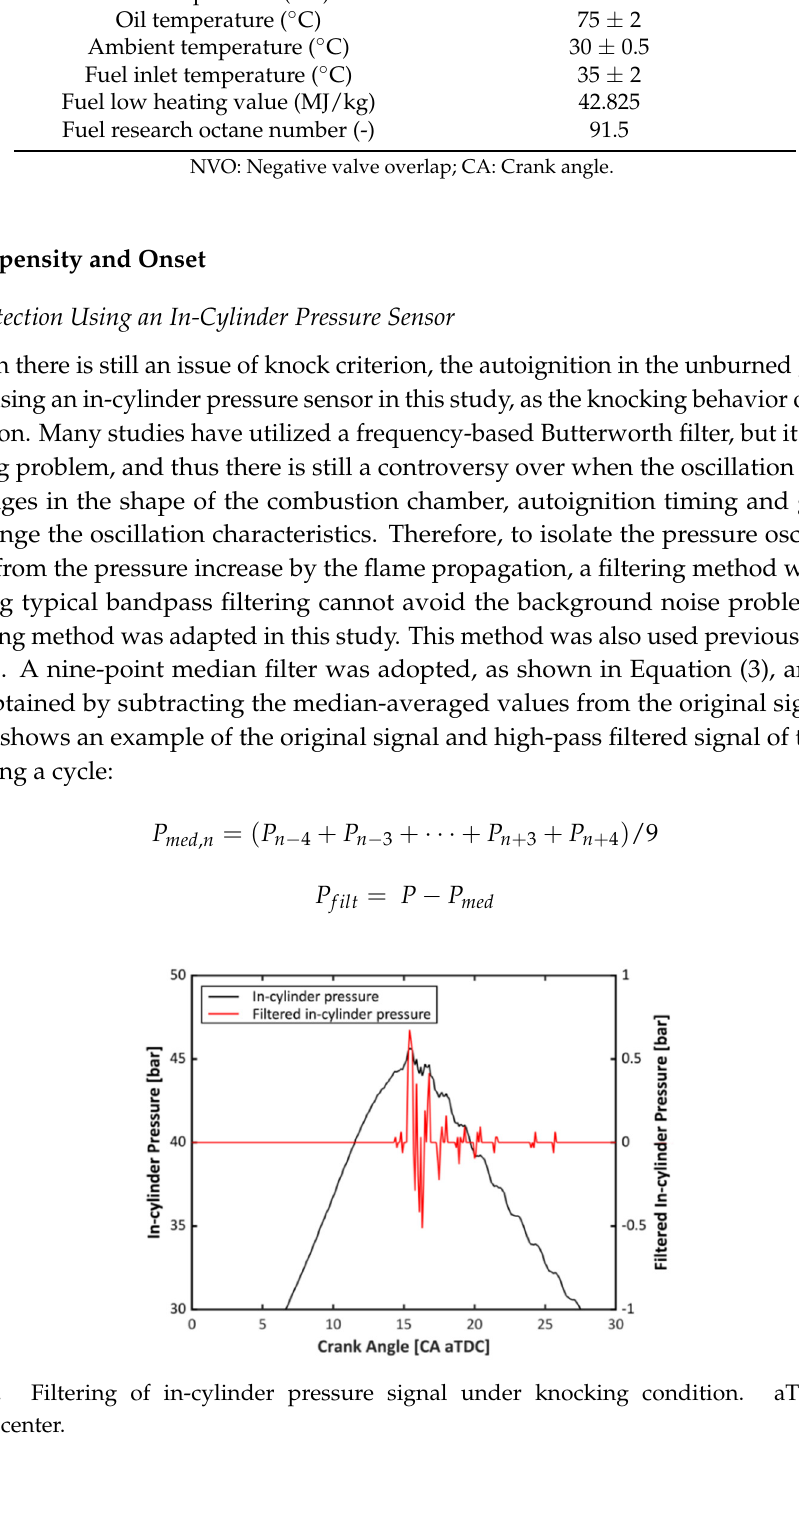
Table 3. Engine experimental conditions